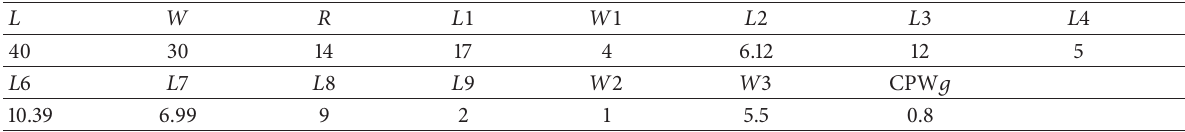
Table 1: Optimized antenna parameter (mm).